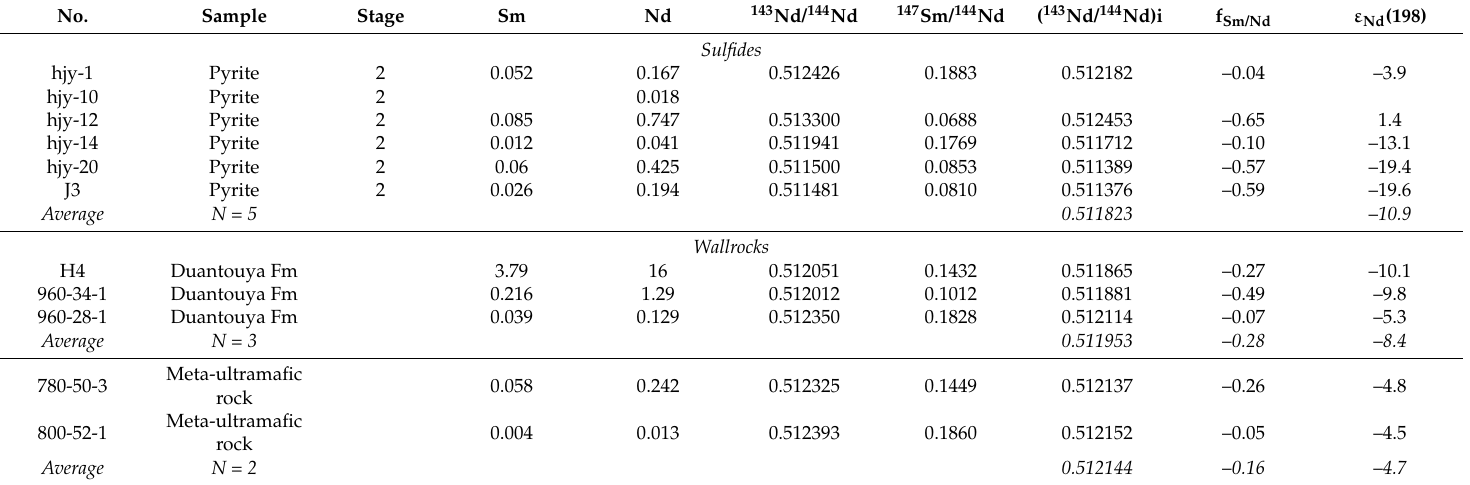
Table 6. The Nd isotope ratios of sulfides and wallrocks at the Jianchaling